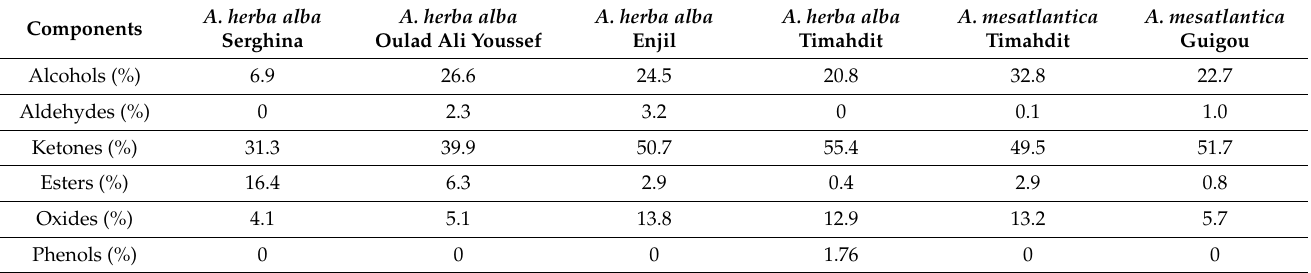
Table 4. Overall percentages (%) of the different chemical families identified in the EO of A. herba alba Asso: Oulad aliyoussef, Serghina, Enjil and Timahdit; A. mesatlantica Maire: Guigou and